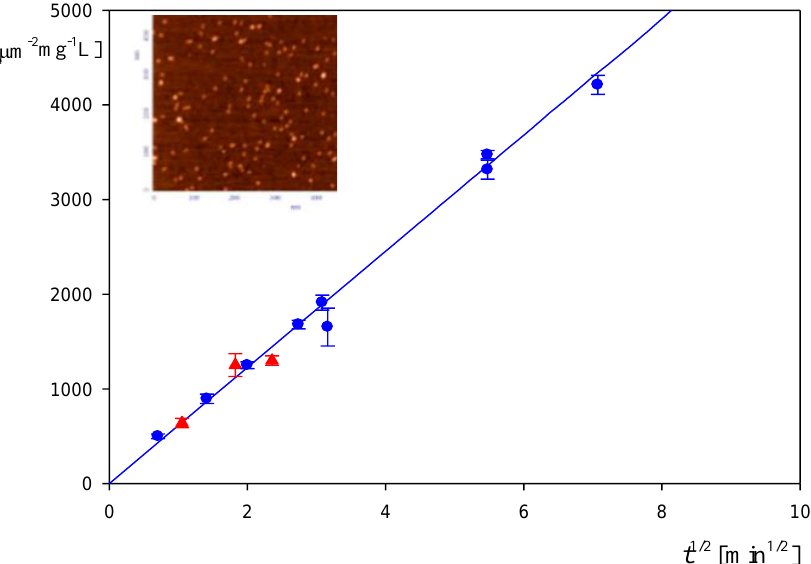
Figure 2. Dependence of the normalized surface concentration of HSA, N/c b [ µ m − 2 mg − 1 L], on the square root of the adsorption time t 1/2 [min 1/2 ]. The points denote experimental results obtained by a direct atomic force microscopy (AFM) enumeration of adsorbed HSA molecules on mica: pH 3.5, 10 mM NaCl, ( ▲ ) c b = 0.1 mg L − 1 , ( ● ) c b = 0. 5 mg L − 1 . The solid line shows the theoretical results calculated from Equation (2). The inset shows the AFM image of the HSA layer on mica.